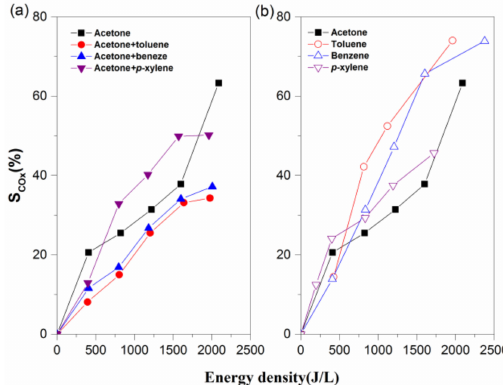
Figure 3. Effects of energy density on the Sco x of the binary ( a ) and single-component ( b ) volatile organic compound (VOC) degradation processes. Reaction conditions: acetone: 250 ppm, BTEX: 50 ppm, RH: 50%, and total flow: 2